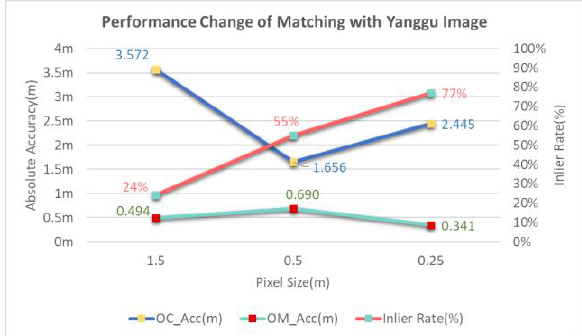
Figure 12. Performance change of matching with Yanggu Kompsat-3A